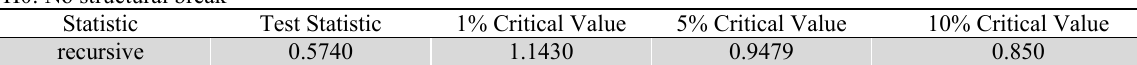
Break test to ARDL (1,2,4,4) model Cumulative sum test for parameter